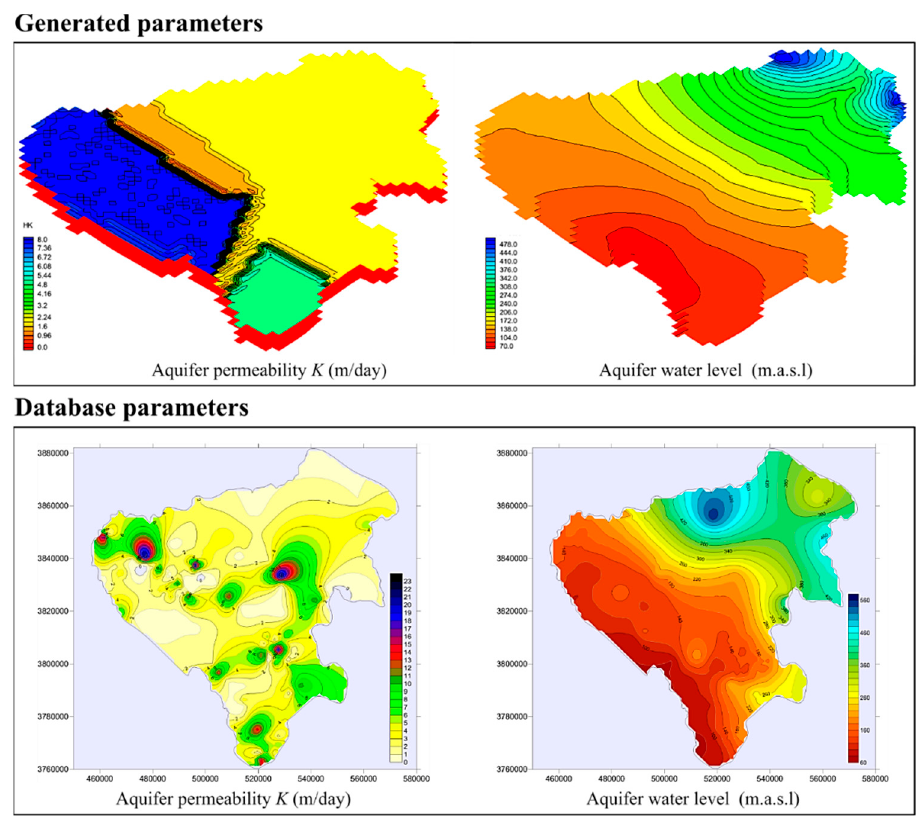
Figure 4. Generated parameters from MODFLOW model implementation in comparison with the database parameters for the aquifer permeability in meters/day and groundwater level in meters (above sea level), respectively.